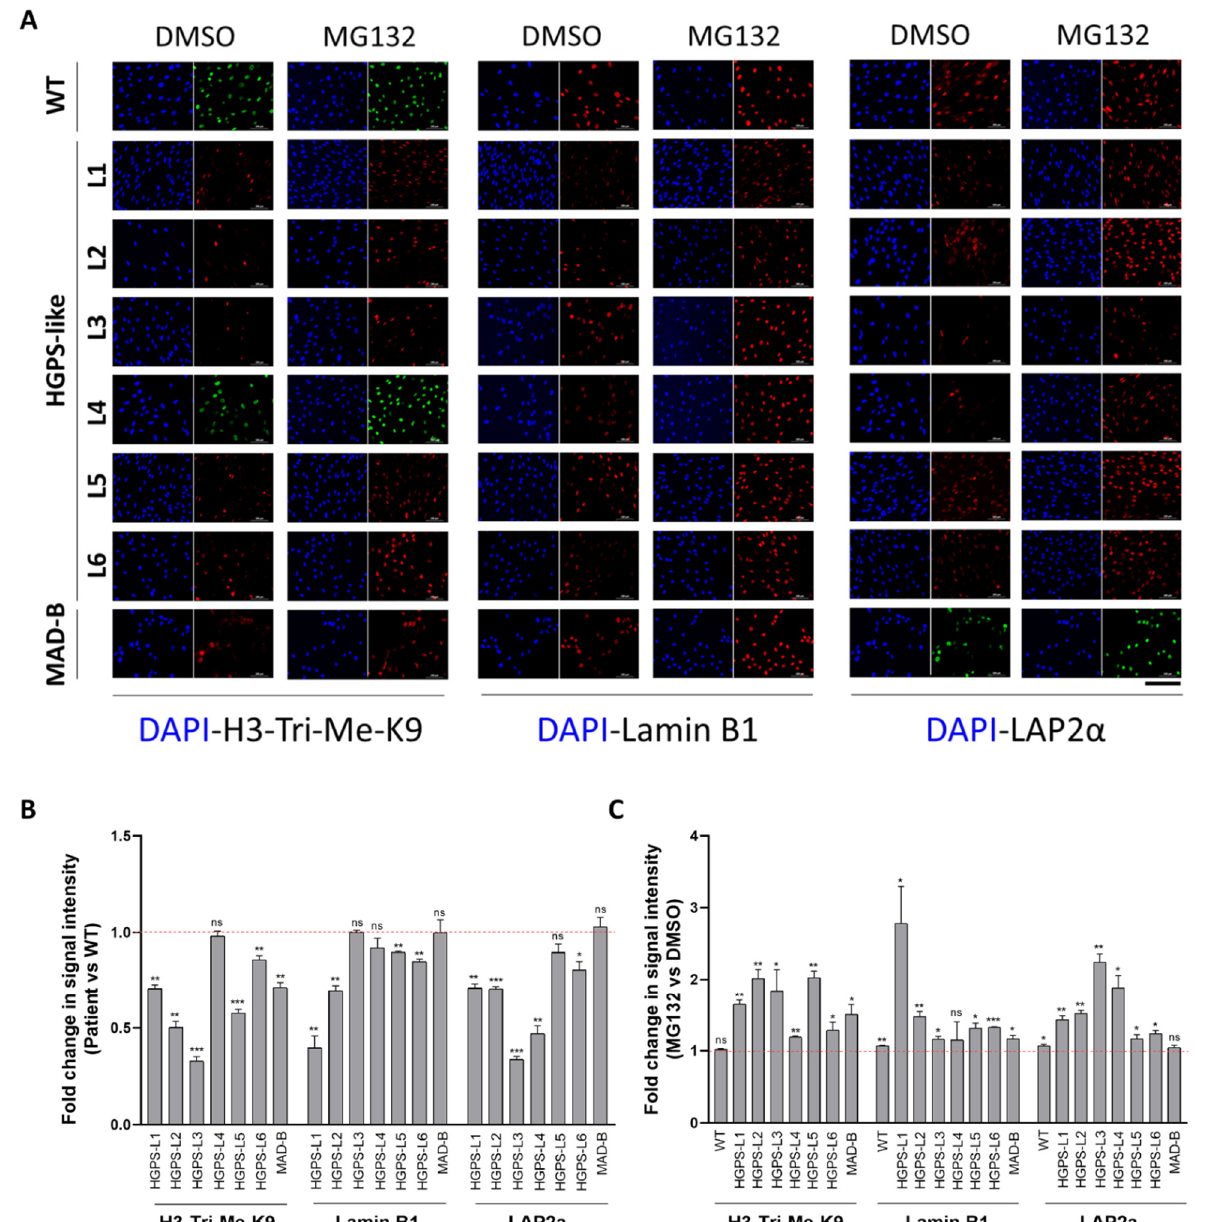
Figure 4. MG132 treatment rescues the level of proteins, the expression of which is altered in HGPS- like and MAD-B cells. ( A ) Immunofluorescence microscopy on primary dermal fibroblasts from a healthy individual (WT) and HGPS-like and MAD-B patients, treated with 500 nM MG132 or an equal volume of DMSO for 48 h. Cells were stained with DAPI (blue) and antibodies to tri-methyl lysine 9 of core histone H3 (H3-Tri-Me-k9), lamin B1, and LAP2 α . ( B ) Fold change in signal intensity in DMSO-treated patient’s cells relative to DMSO-treated WT cells, each normalized to the corresponding nuclei number. The signal intensity was set to 1 in DMSO-treated WT cells (mean ± SEM, n = 3, Student’s t -test, * p < 0.05, ** p < 0.01, *** p < 0.001). ( C ) Fold change in signal intensity in MG132-treated relative to DMSO-treated HGPS fibroblasts, each normalized to the corresponding nuclei number. The signal intensity was set to 1 in DMSO-treated cells. At least 200 fibroblast nuclei were randomly selected for each cell line (mean ± SEM, n = 3, Student’s t -test, * p < 0.05, ** p < 0.01, *** p < 0.001) and examined using ImageJ software. Scale bar, 200 µm.